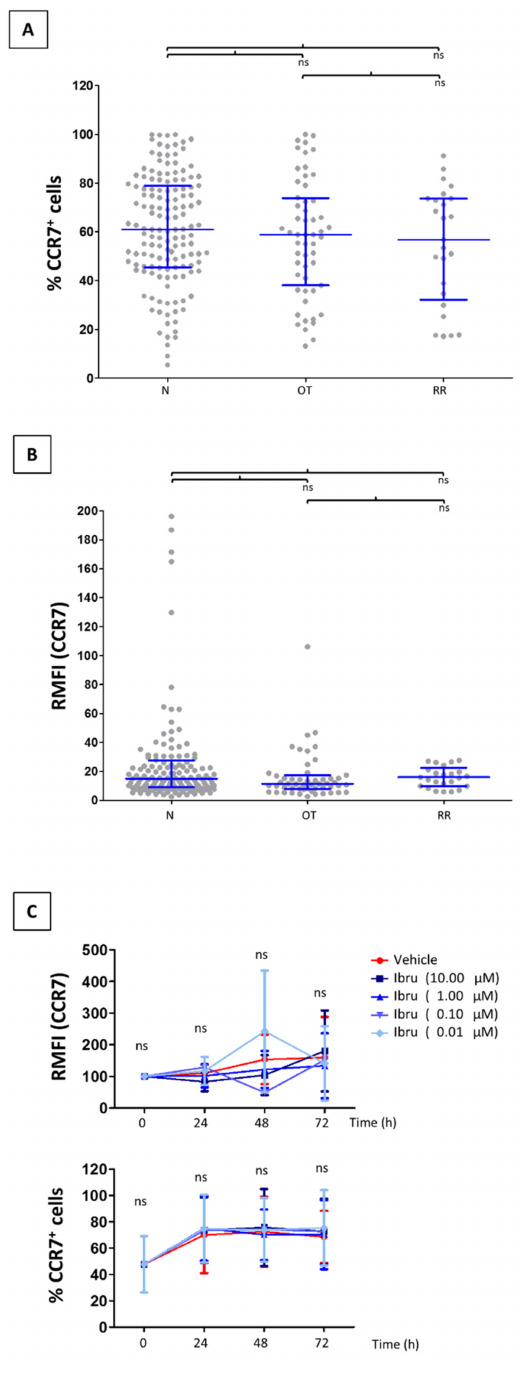
Figure 1. Ibrutinib does not modify CCR7 expression in chronic lymphocytic leukemia (CLL) T-cells from treated patients. ( A , B ) The expression of surface CCR7 was analyzed in terms of proportion of CLL T-cells expressing the receptor or of relative median fluorescence intensity (RMFI, relative to an irrelevant isotype control, arbitrary units). Expression was determined in PB samples from naïve patients (N, n = 144), patients on current treatment with ibrutinib (OT, n = 52), or patients with ibrutinib relapsed/refractory CLL (RR, n = 19). The graphs represent the median ± interquartile range. ( C ) CCR7 expression is maintained in CLL T-cells after in vitro incubation with ibrutinib. CLL T-cells from treatment-naïve patients (n = 7) were incubated for 72 h in the presence of ibrutinib at different final concentrations (0/DMSO; 0.01; 0.1; 1; 10 µ M). At time 0, and every 24 h, CCR7 expression was determined by flow cytometry. The graphs show the proportion of CLL T-cells expressing CCR7, or the RMFI (arbitrary units). In all graphs: ns, not